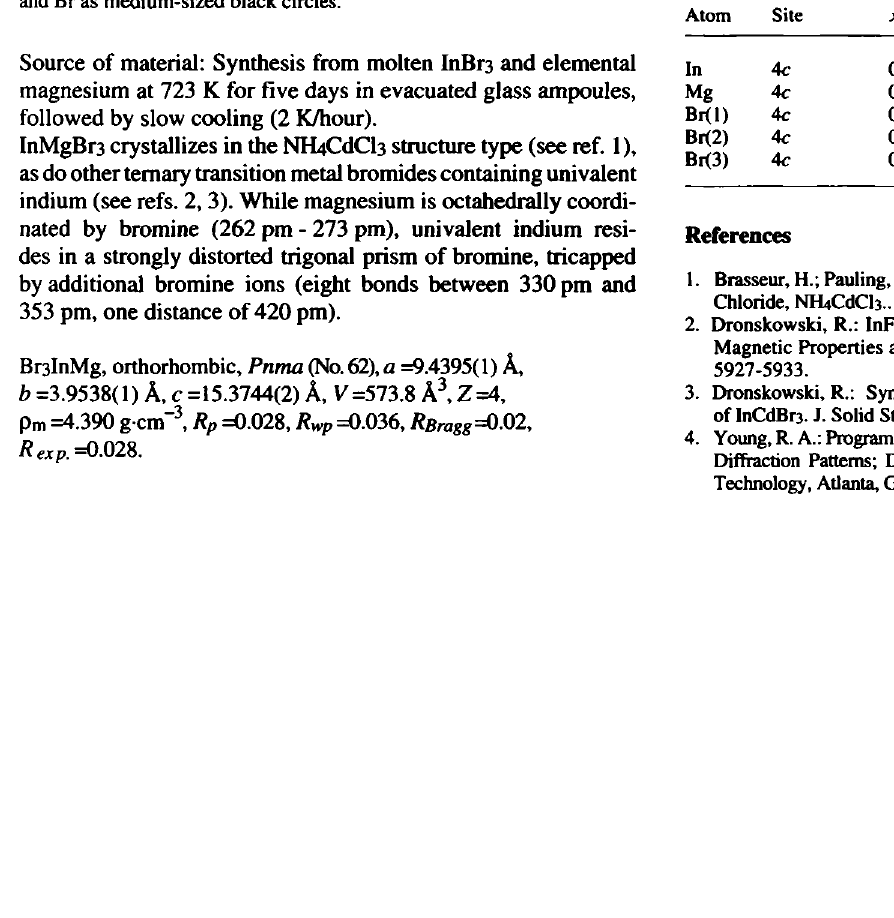
Table 2. Final atomic coordinates and displacement parameters (in Â 2